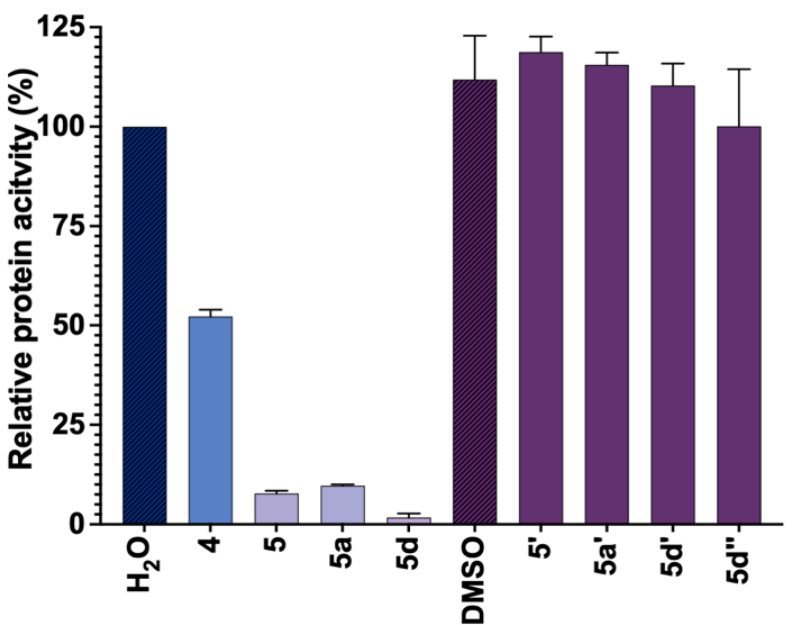
Figure 8. Screening of the third library of inhibitors. Inhibitory potency of compounds 5’, 5a’, 5d’, and 5d” as compared to their nucleotide counterparts ( 5 , 5a , and 5d ) (each at 100 µ M). Compound 4 was used as a positive control. Depending on the solubility of compounds, their stock solution was prepared in water (blue) or DMSO (purple), and hence the control reactions for both solvents are shown. The data represents mean value ± SD from duplicate experiment.